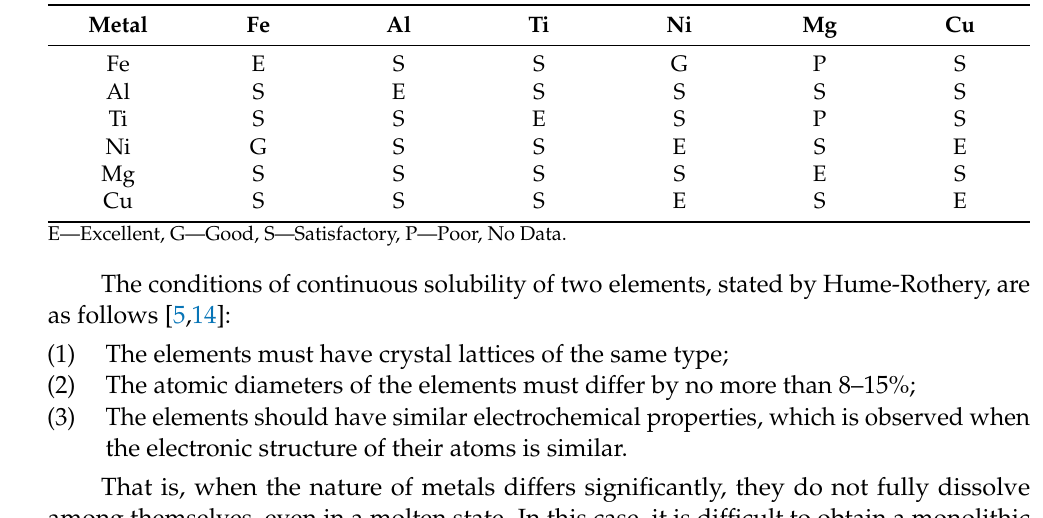
Table 1. Weldability of binary metal combinations